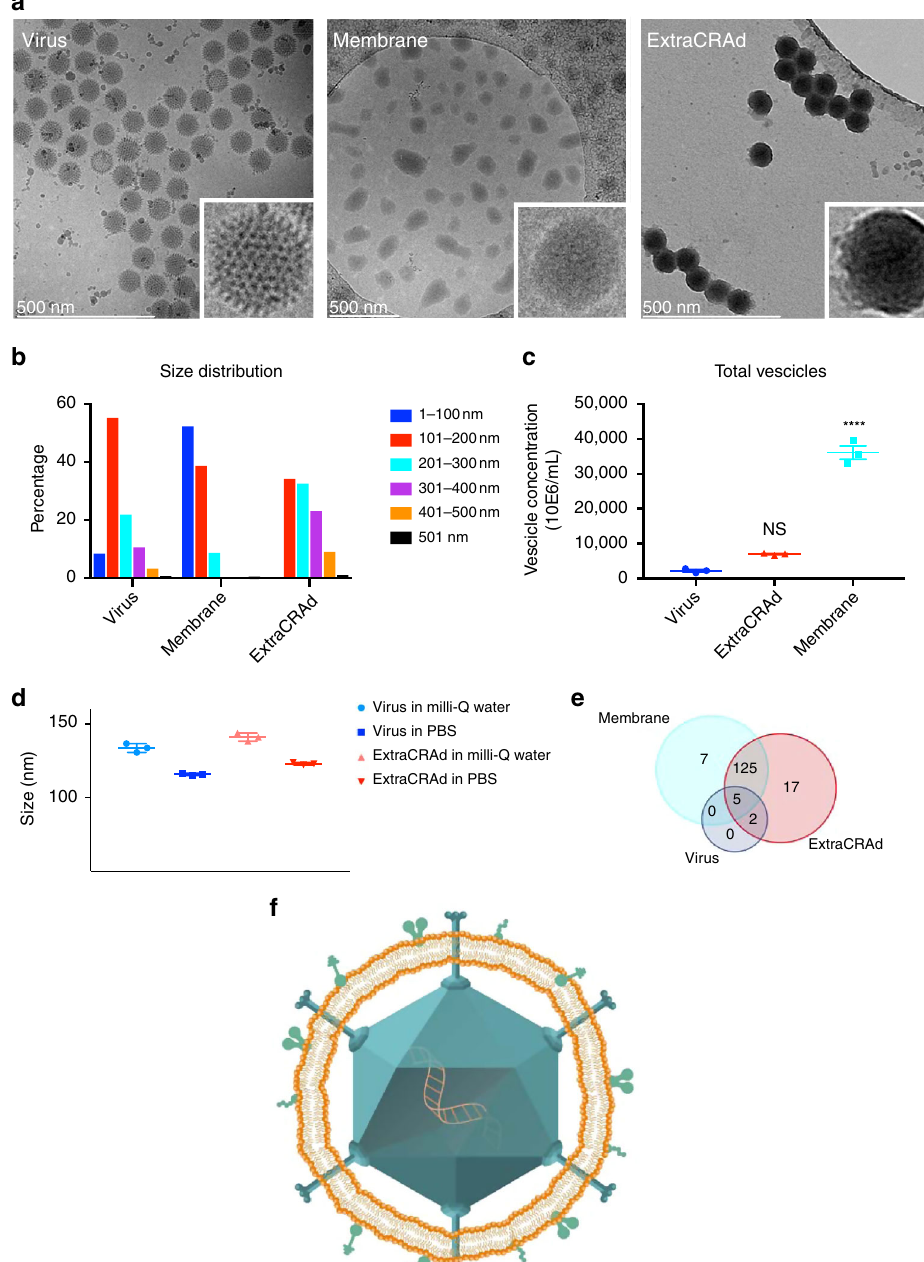
Fig. 2 Physical characterization of ExtraCRAd. A Cryo-transmission electron microscopy (TEM) images of a virus, b lipid cancer membrane vesicles, and c ExtraCRAd. B16.OVA cell line was employed as source for the membrane. Scale bar: 500 nm. The insets on the right were magni fi ed ten times compared to the original image. b Nano-tracking analysis (NTA) showing the size distribution of the samples. The size distribution is expressed as percentage of the total population. The size intervals are presented on the right. c NTA quanti fi cation of the concentration of viral particles or nanosized vesicles in the samples. The results are presented as number × 10 6 vesicles per ml. The data were analyzed by two-way ANOVA followed by Tukey ’ s post-test. The level of statistical signi fi cance was set at probability level **** p < 0.0001. d Dynamic light scattering (DLS) size analysis of the system in different extrusion buffers. The results are presented as mean ± s.d. ( n = 3). e Venn-diagram representing the results retrieved from the mass spectrometry analysis of the samples (virus, ExtraCRAd produced with membranes derived from human lung cancer A549 cells and extruded membrane vesicles from A549 cells). The Venn size re fl ects the total number of unique proteoforms for each sample, with the shared proteins presented in the intersection of the diagrams. f Graphic illustration of an ExtraCRAd: adenovirus 5-D24-CpG (light blue), lipid membrane (orange), and proteins (light green). The error bars indicate